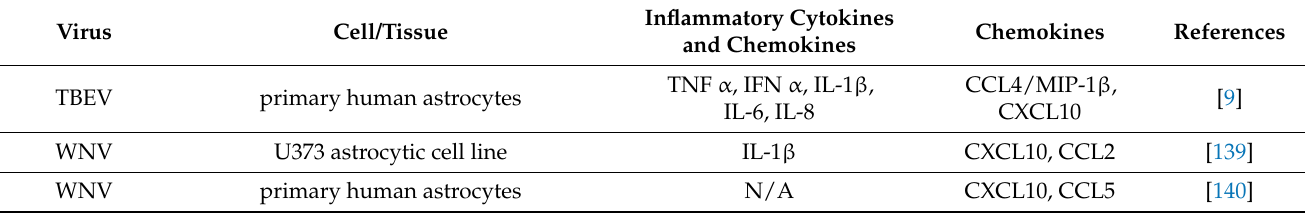
Table 2. Expression of cytokines and interferons in virus-infected